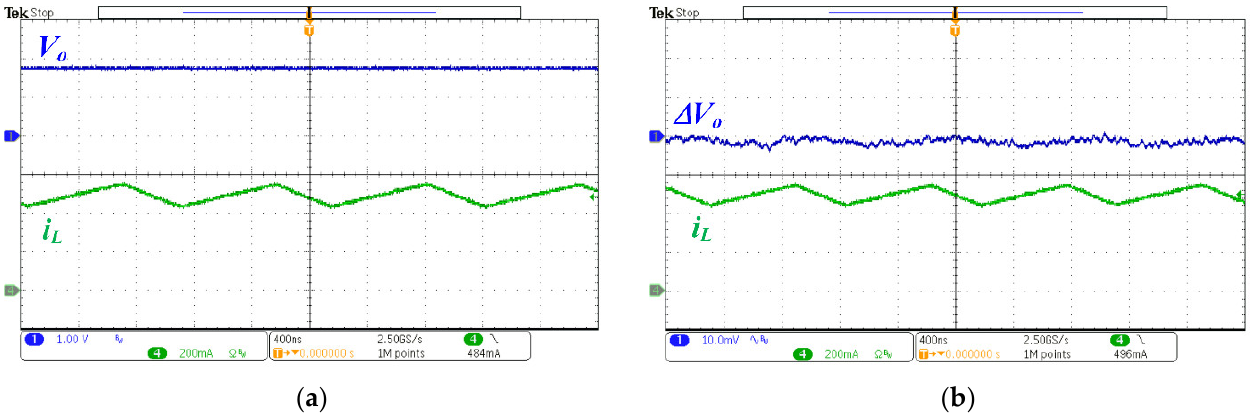
( b ) Figure 15. Measured transient waveforms of the proposed buck converter for ( a ) step-down and ( b ) step-up loads. Figure 16 plots the switching frequency of the buck converter versus load currents without and with AOT function. It can be found that the differences in switching frequency without and with AOT function were about 79 kHz and 11 kHz, respectively. The switching frequency with AOT control was kept approximately constant at different load currents. Figure 17 plots the measured efficiency of the proposed converter when the load current changed from 50 mA to 500 mA. The maximum efficiency of the proposed converter was 90.9% at a load current of 200 mA. A comparison of results with previously proposed on-time controlled buck converters is summarized in Table 1. The performance of f sw variation is indicated by (Δ f sw / f sw ) and (Δ f sw /ΔI Load ). The performance of the proposed buck converter was comparable to those with different control techniques. Figure 16. Switching frequency versus different load currents with and without AOT function.